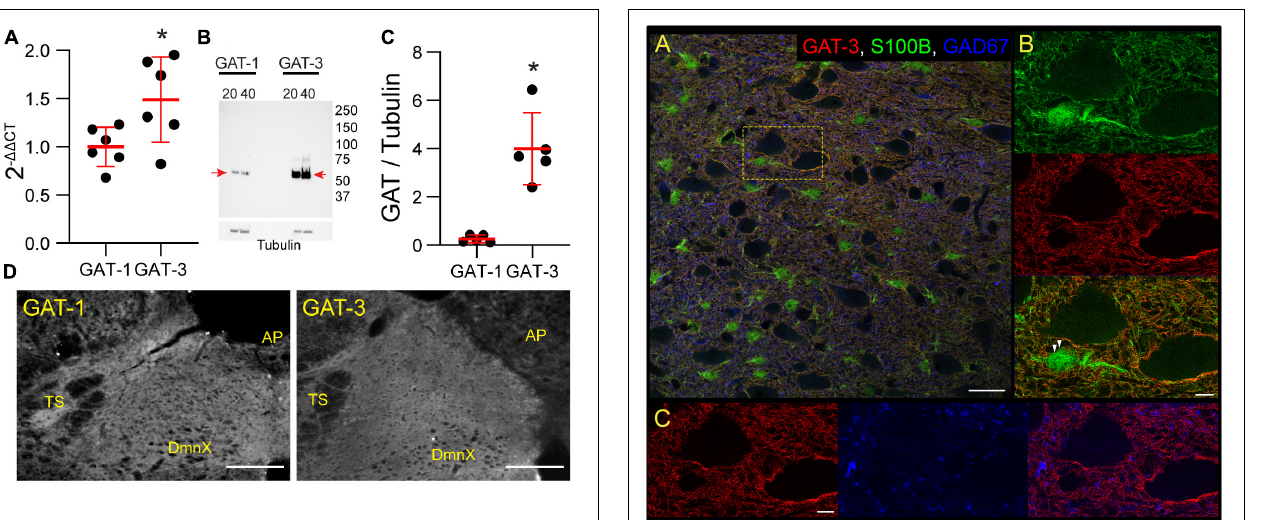
S100B ( Figures 2A,B ) and its proximity to GAD67